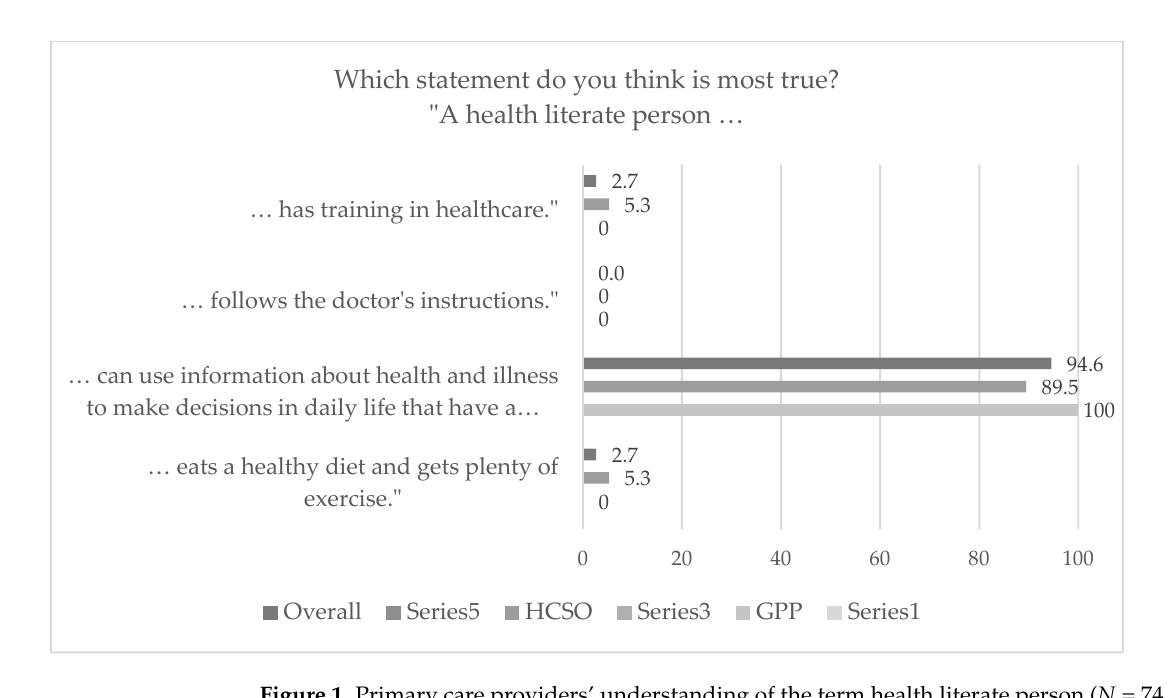
Figure 1. Primary care providers’ understanding of the term health literate person ( N = 74 overall, data in %). HCSO = home care service organization; GPP = general practitioners’ practice.